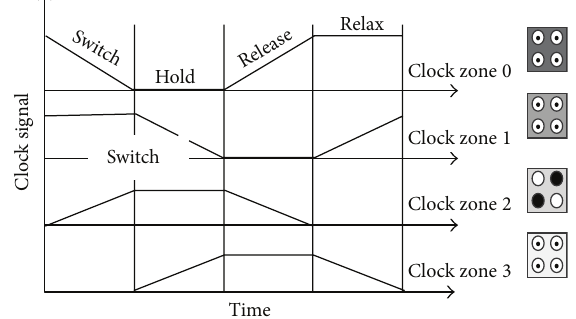
Figure 6: The four phases of the QCA clocking.